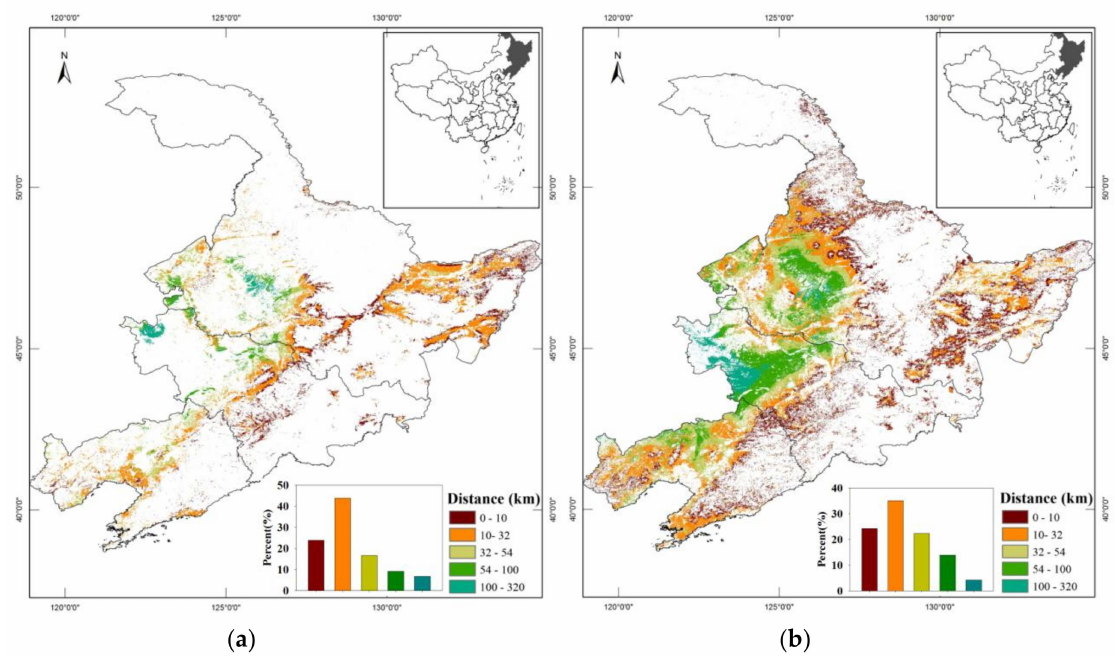
Figure 8. Spatial distribution of the distance between cropland pixels and adjacent forests pixels in Northeast China. ( a ) the distance from forest to irrigated cropland pixels, ( b ) the distance from forest to non-irrigated cropland